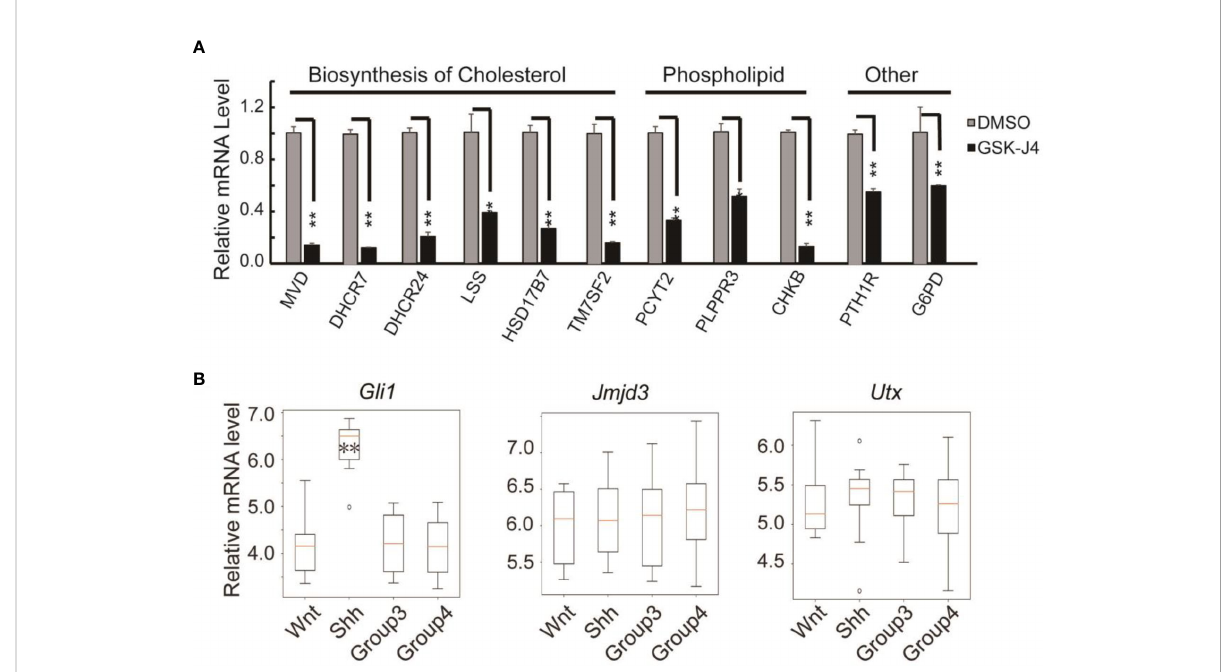
FIGURE 7 Veri fi cation of cholesterol and phospholipids biosynthesis gene expression decreases in DaoY cells treated with GSK-J4. (A) RT-qPCR veri fi cation of the expression of cholesterol and phospholipids biosynthesis genes in DaoY cells treated with GSK-J4. (B) Gene expression levels by microarray analysis in four subgroups of human medulloblastoma (GSE37418 (7)). Number of samples in each group, wnt: 8, Shh: 10, Group3: 17, Group4: 41. Signi fi cance determined using Student ’ s t-test. ** p < 0.01, * p <